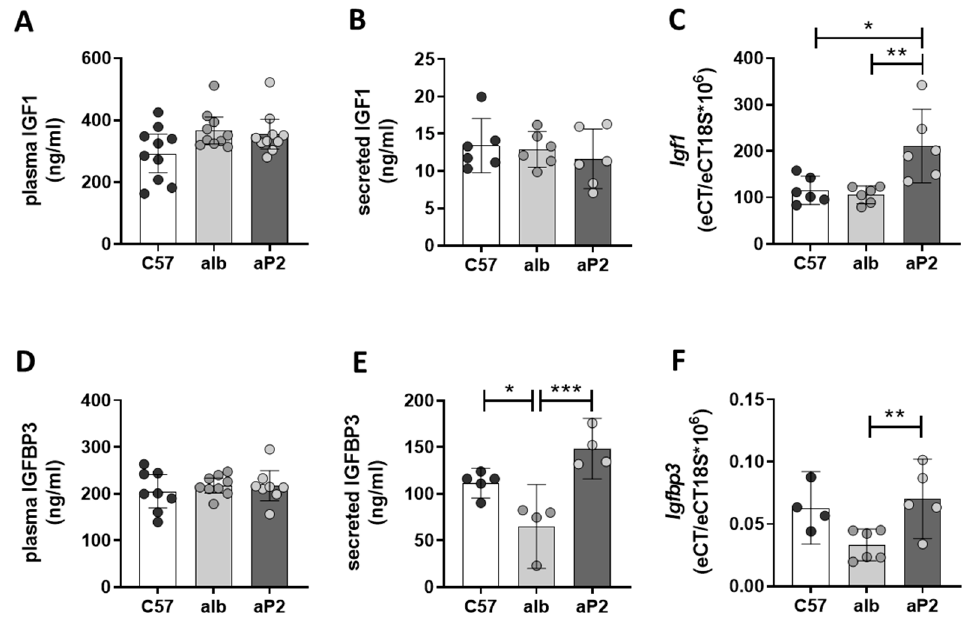
Figure 3. IGF1 and IGFBP3 in mouse models. IGF1 and IGFBP3 levels in plasma ( A , D ), culture supernatants ( B , E ), and mRNA expression ( C , F ) in primary hepatocytes from C57Bl6 (C57), alb-SREBP-1c (alb), and aP2-SREBP-1c (aP2) mice. Data are expressed as mean (±95% CI; n = 4–10). Statistics: ANOVA with Sidak correction: *** p < 0.001, ** p < 0.01 and * p < 0.05.